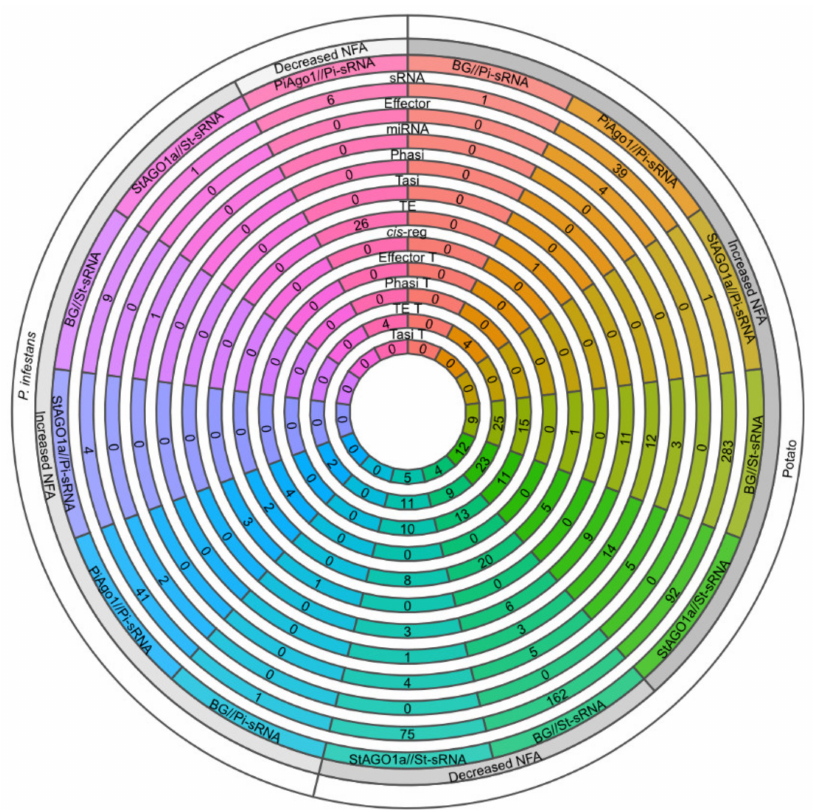
Figure 4. Precursor and target site summary (number of genes excluded) of sRNA targeting in potato and P. infestans . White ring: the targeted genome. Gray ring: specifies increased or decreased NFA upon infection. Subsequent rings towards the center corresponds to different materials, RNA classes, and number of sRNAs related to each class. All classes denoted ¨ T ¨ in the end implies that the class corresponds to the target site. TE (transposons and repeats), cis -reg ( cis -regulatory sRNAs), phasi (phasiRNAs), and tasi (tasiRNAs) are according to